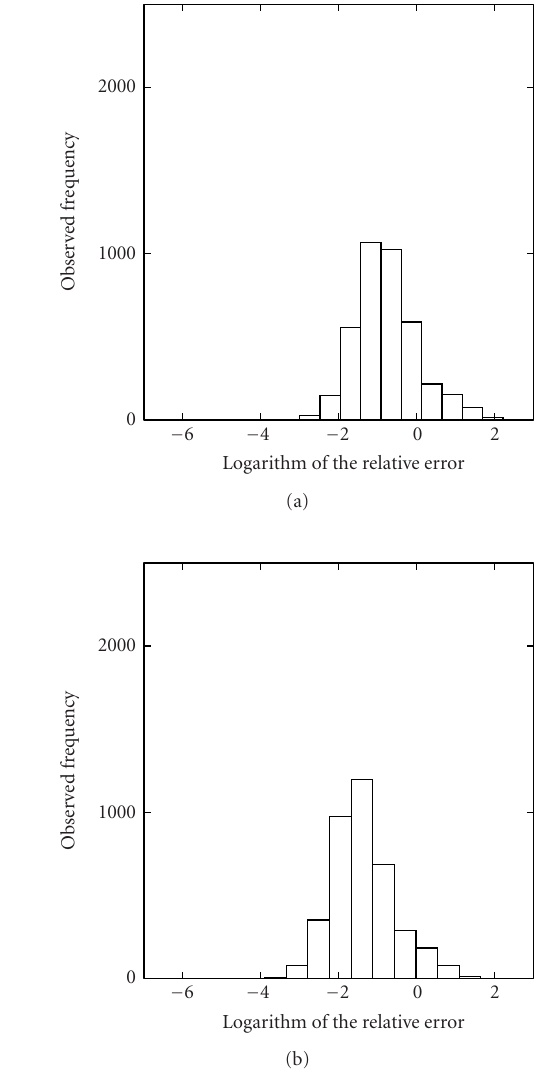
Figure 8: Histogram of logarithmic relative error values for the ff t- gen FFT with input signals x (a) and 4 x (b), the error increases to the